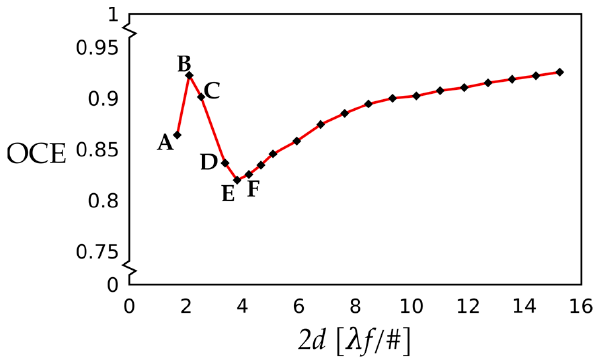
Figure 9. The OCE as a function of pixel size in [ λ F/# ] for an optical system with a central rectangular obscuration (see Figure 5a). We observed a sharp increase in the OCE value toward the first peak to about 0.93 at about 2.05 pixels (Point B), followed by a sharp dip to about 0.82 (Point E) at about 4 pixels. Only from this, the lowest point on the curve, its shape starts to increase in a monotonical fashion.